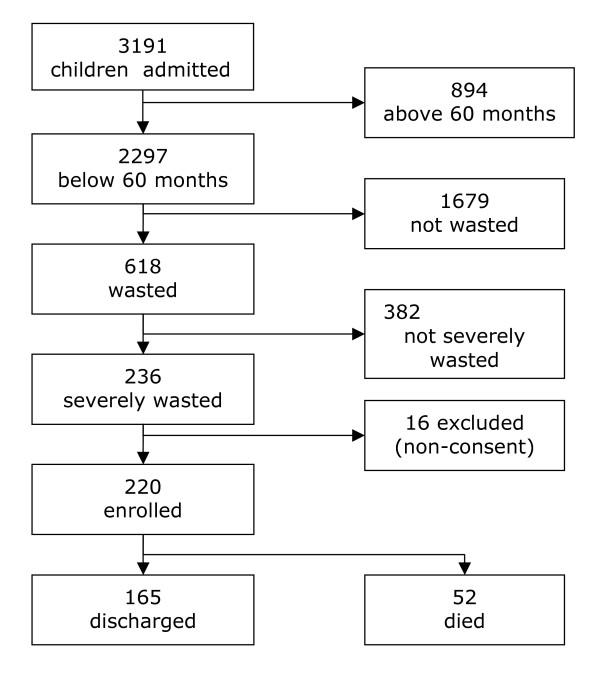
Study profile showing the process of enrolment of the 220 children with severe malnutrition below 60 months of age in Mulago hospital, Uganda, September – November 2003.